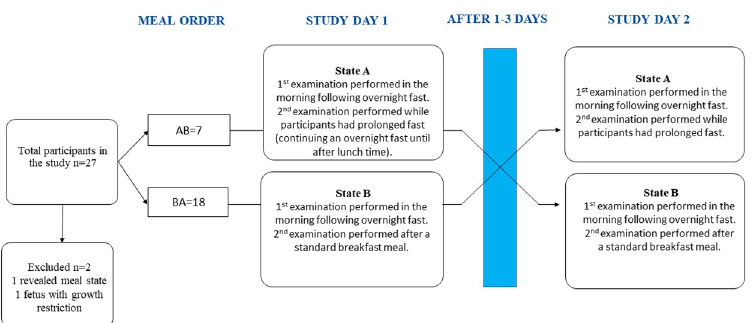
Fig 1. Study design flowchart. Each participant was examined twice: on study day 1 and study day 2 (each separated by 1–3 days). The order of the two meal states A and B, were allocated to participants to either: AB (state A study day 1 and state B study day 2), or BA (state B study day 1 and state A study day 2).